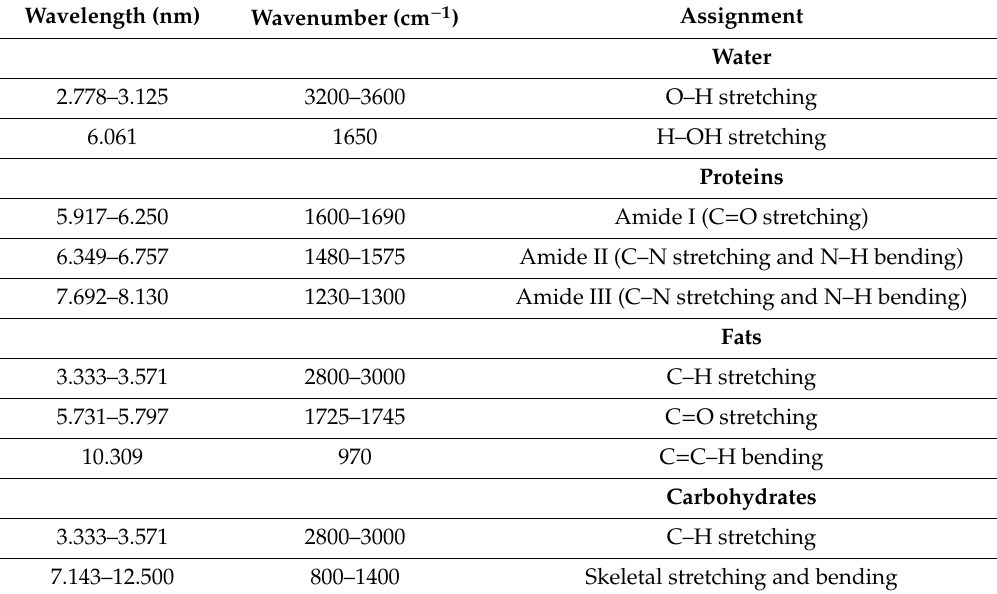
Table 2. Examples of MIR absorption bands